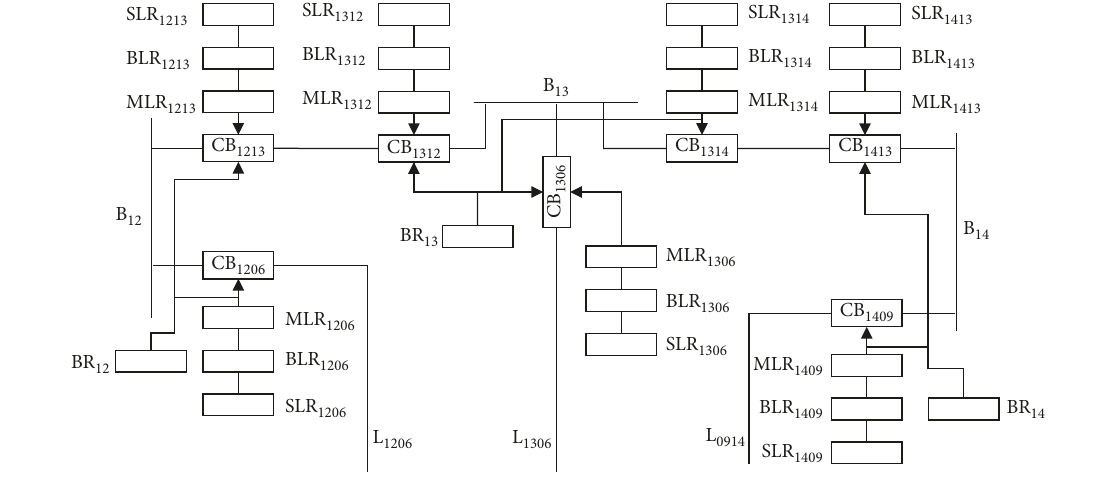
Figure 9: The protection configuration of S6. Table 4: Fault production rule set of